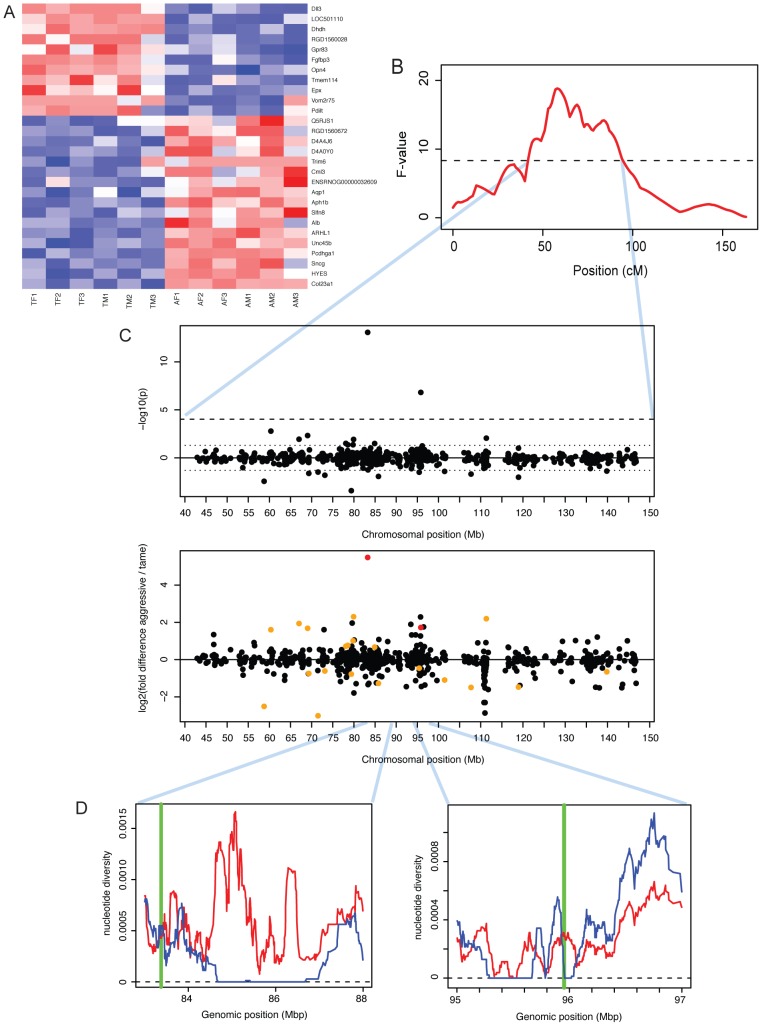
Expression differences between tame and aggressive rats.A. Heatmap showing expression levels of DE genes. Genes were individually normalized and sorted by DE p-value, separately for genes up- and downregulated in domestication. Red (blue): lower (higher) expression. B. A QTL for tameness is located on chromosome one [25]. The x-axis shows the genetic position along chromosome one in centiMorgan (cM). The F-value is a measure of the likelihood of the presence of a QTL. The dashed horizontal line is the genome-wide significance threshold. See [25] for details. C. Expression differences in the tameness QTL region. Top panel: significance and location for each gene. P-values were signed so that positive (negative) values correspond to genes with higher expression in aggressive (tame) rats. Dashed lines: genome-wide 10% FDR threshold, dotted lines: p = 0.05. Lower panel: fold changes. Red: genes with FDR<10%, orange: genes with p<0.05. D: positions of Dll3 and Dhdh (green vertical lines) compared to patterns of DNA polymorphism in the founder animals of the QTL pedigree used to identify the tameness QTL [49]. Blue (red) line: nucleotide diversity in the tame (aggressive) founder animals.